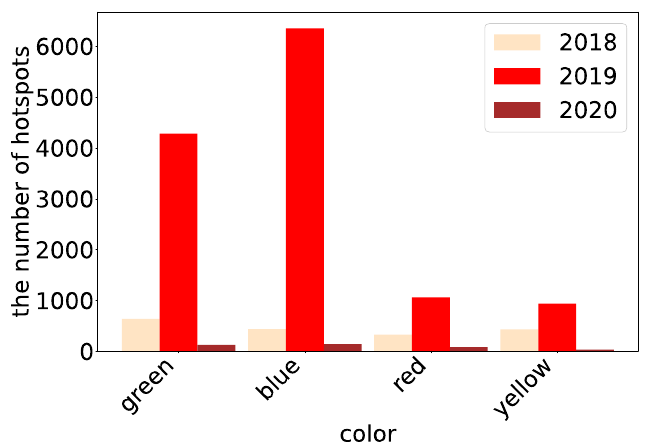
Figure 17. Total number of fire hotspots summed over the pixels corresponding to each color.